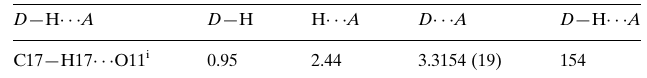
Hydrogen-bond geometry (A˚ , (cid:3)